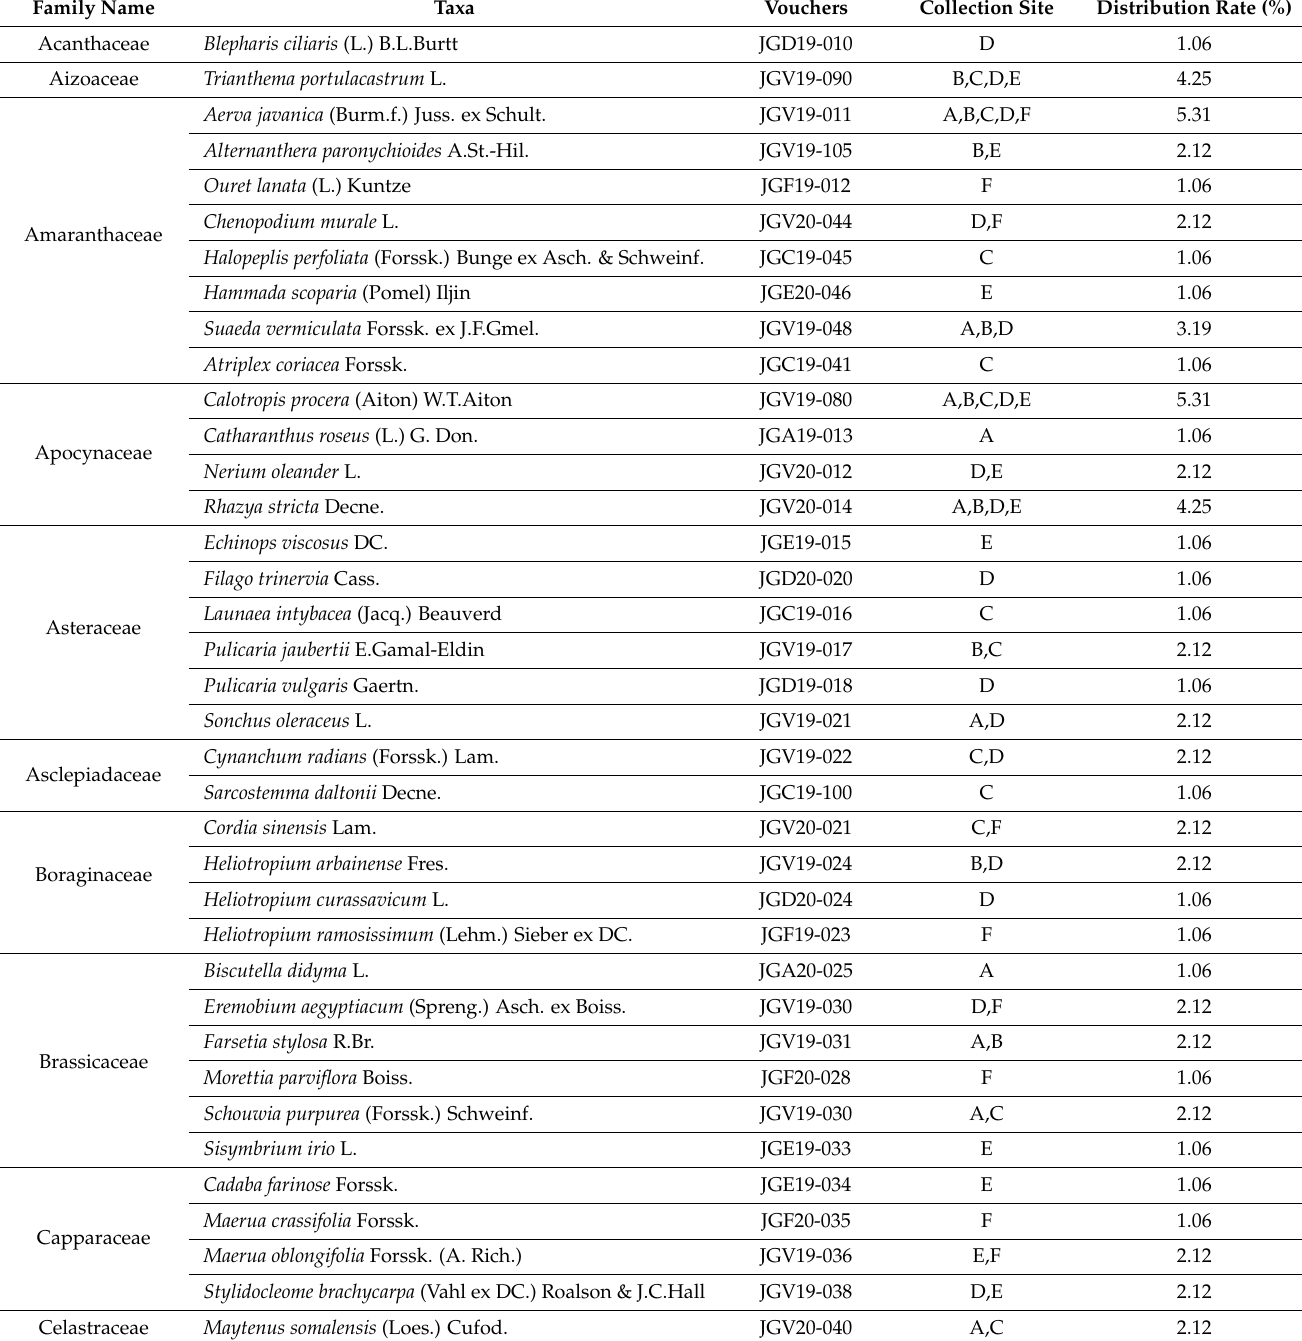
Table 1. The plant taxa recorded in Aljumum, family name, collection site, and distribution rate (%) within the study zones. Zones’ longitude and latitude, respectively. (A) Rehat and Madrakah: 39.721480, 21.669101; (B) Hada Al-Sham: 39.586325, 21.662486; (C) Osfan: 39.475741, 21.666860; (D) Al-Fawara: 39.700831, 21.530311; (E) Wadi Al-Rayan and